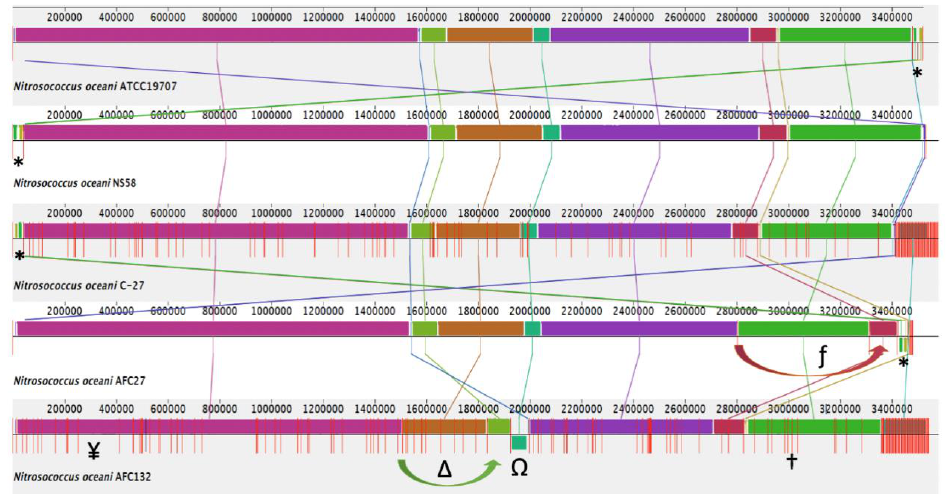
Figure 2. Alignment of the genome sequences from five Nitrosococcus oceani strains C-107, NS58, C- 27, AFC27, and AFC132, using Mauve 2.4 [37], the progressiveMauve aligner [40], and the Mauve Contig Mover module [39 ]. *, Plasmid A sequence; Ω, inverted AFC132 contig_72; ∆, translocated AFC132 contig_71; ƒ, translocated AFC27 contig_NS_D5995302.1; †, NiFe -hydrogenase metallocenter